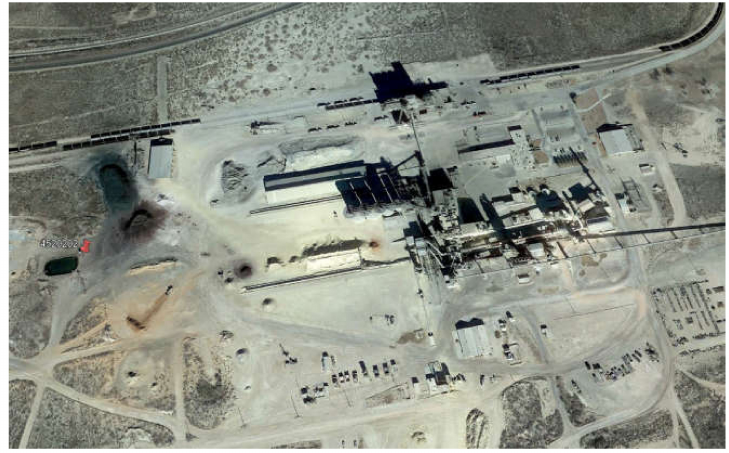
Figure 8. Location of well (ID: 4520202) adjacent to the cement production facility in southwest Ector County (image from Google